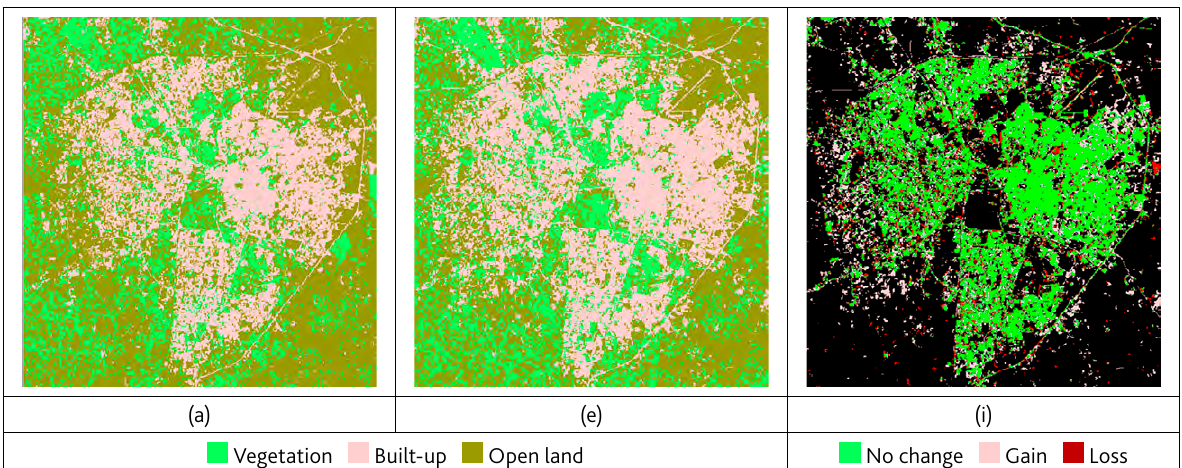
Figure 5. OBCD results using ABETC for Vadodara Data set. (a) Classified Image of the year 2013 (b)